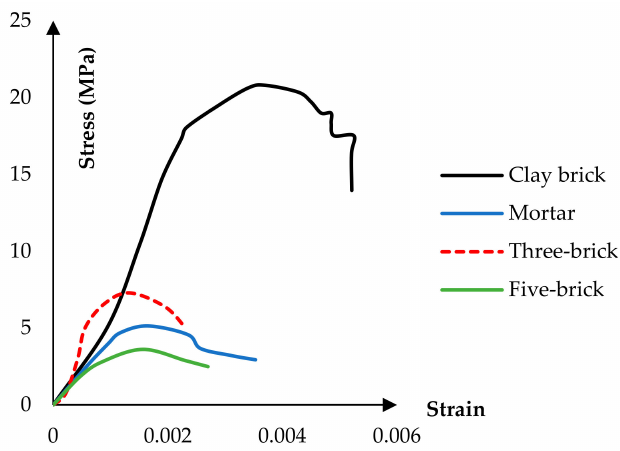
Figure 4. The axial compressive diagram.